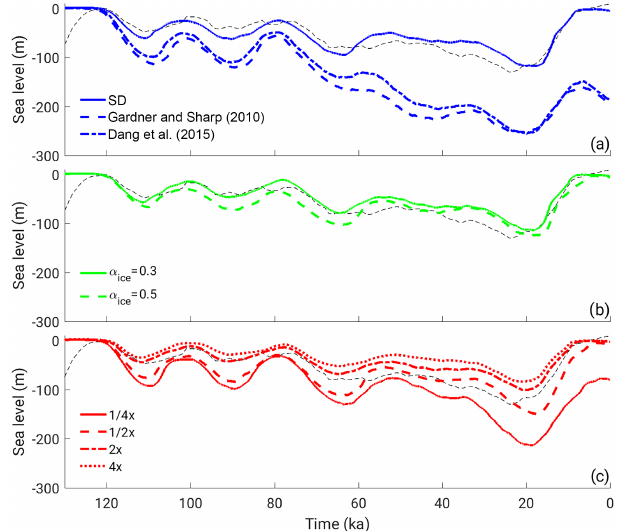
Figure 10. Uncertainties in modelled sea level evolution over the last glacial cycles resulting from different parameterizations of (a) snow albedo, (b) different values of bare ice albedo and (c) scal- ing of dust emissions by factors 1/4, 1/2, 2 and 4. The dashed black line represents the sea level reconstruction from Spratt and Lisiecki